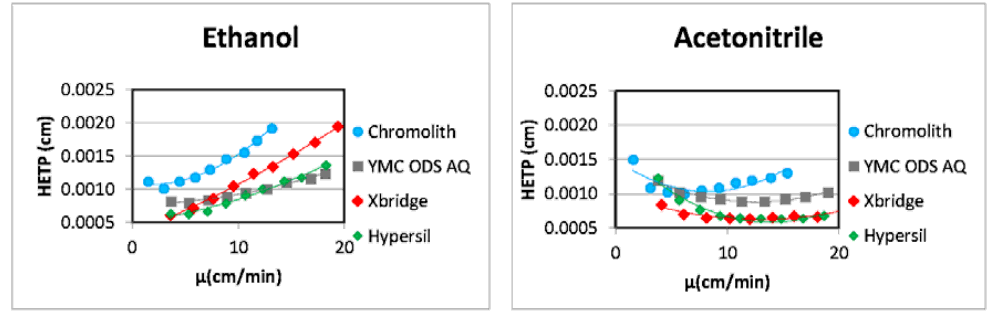
Figure 1. Comparison of Van Deemter curves of atorvastatin obtained using ethanol or acetonitrile in mobile phases. Xbridge BEH Shield RP18 (50 × 4.6 mm i.d., 2.5 μ m); Chromolith (SpeedROD RP18, 50 × 4.6 mm i.d., 2 μ m); YMC ‐ ODS ‐ AQ (50 × 4.6 mm i.d., 3 μ m); Hypersil GOLD (50 × 4.6 mm i.d., 1.9 μ m). Isoeluotropic mobile phases: EtOH/formic acid (pH 2.5, 25 mM) in proportions 40/60 ( v / v ) for YMC column; 38/62 ( v / v ) for Xbridge and Hypersil columns; and 35/65 ( v / v ) for Chromolith column. HETP: height equivalent to a theoretical plate. Similar to Reference [42].